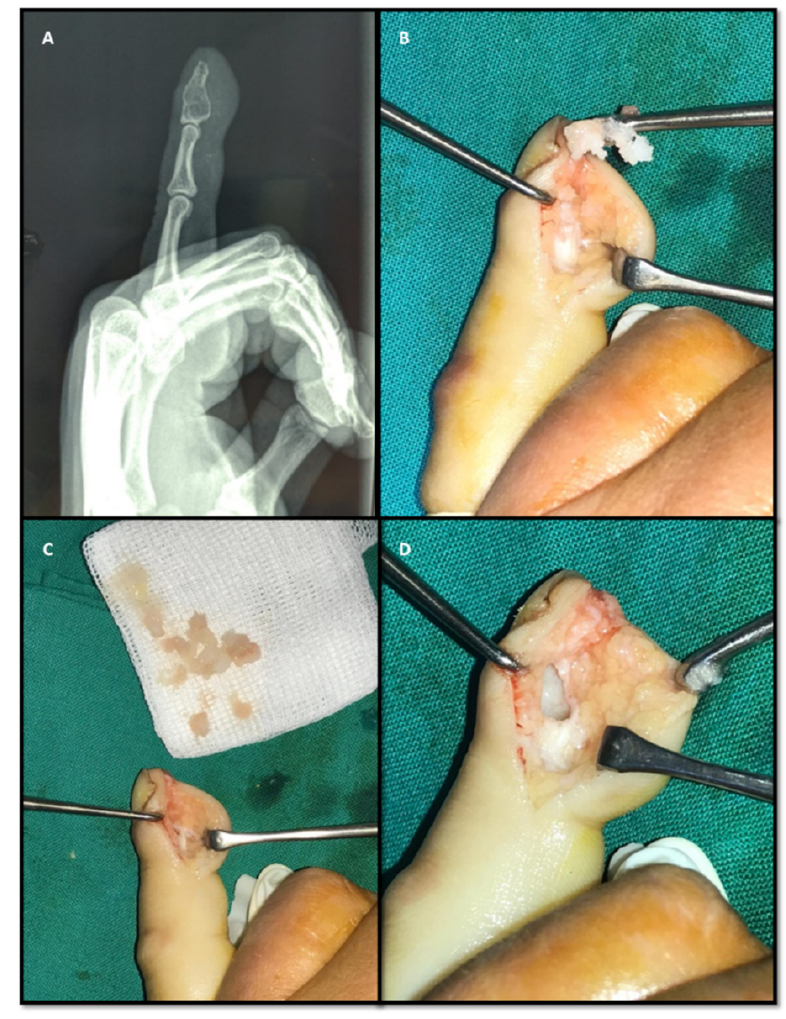
Figure 1. Enchondroma of the distal phalanx. ( A )—radiological finding of enchondroma of the distal phalanx; ( B )—excision of enchondroma using a surgical scoop; ( C )—Excised tumor; ( D )—bone defect after tumor excision, left for natural